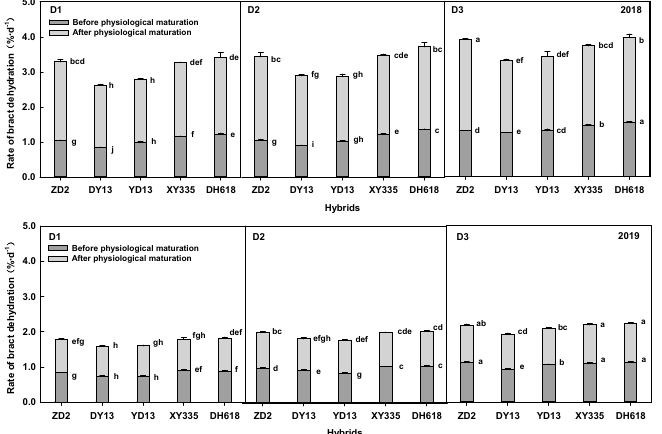
Figure 5. Dehydration rate of bracts of different hybrids under different densities in 2018 and 2019. Different letters on the graph indicate significant differences at p < 0.05.